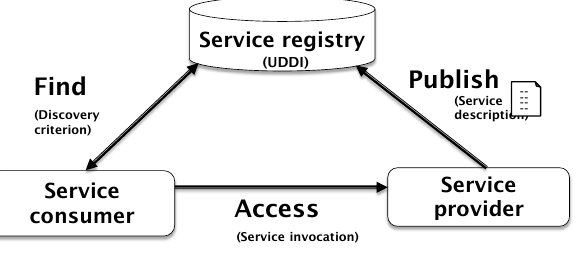
Figure 3. SOA basic